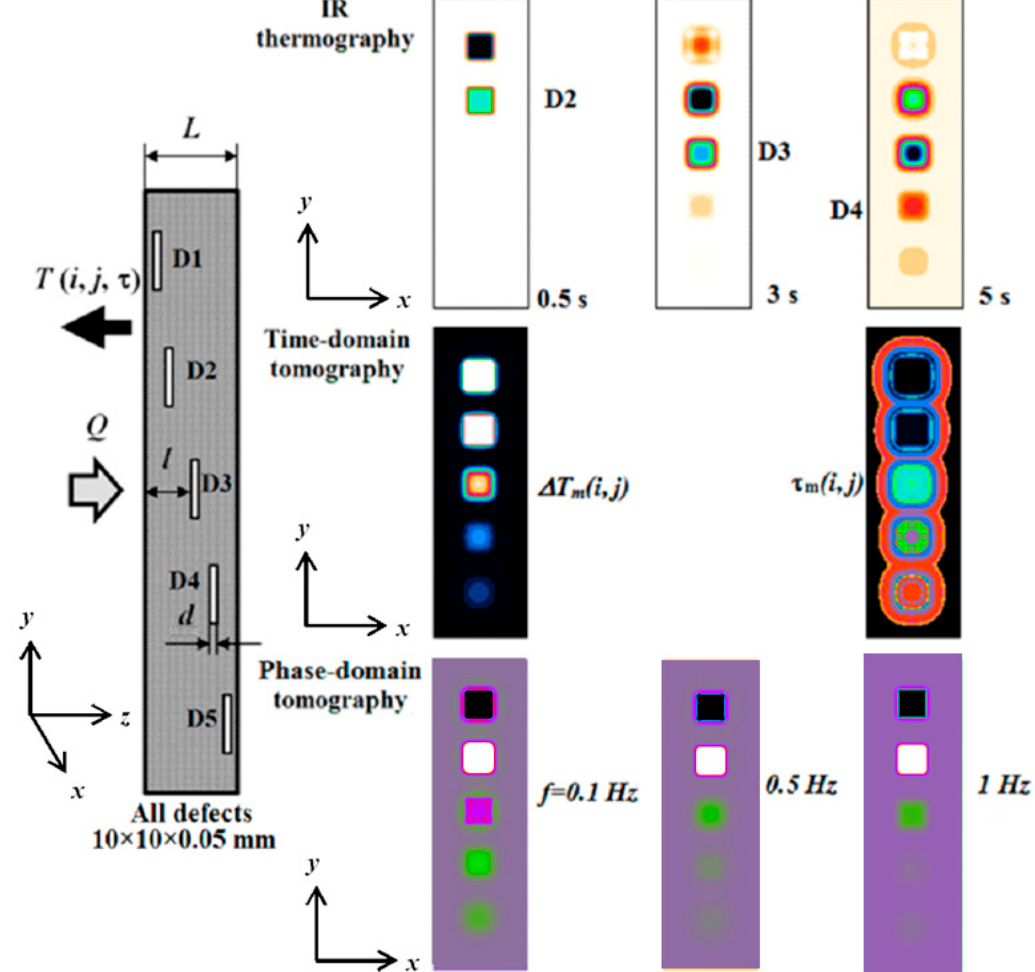
Figure 1. 3D modeling and time/phase data processing in the inspection of CFRP ( L = 3 mm, defect size 10 × 10 × 0.05 mm, l = 0.1; 0.5; 1.475; 2.45 and 2.85 mm).